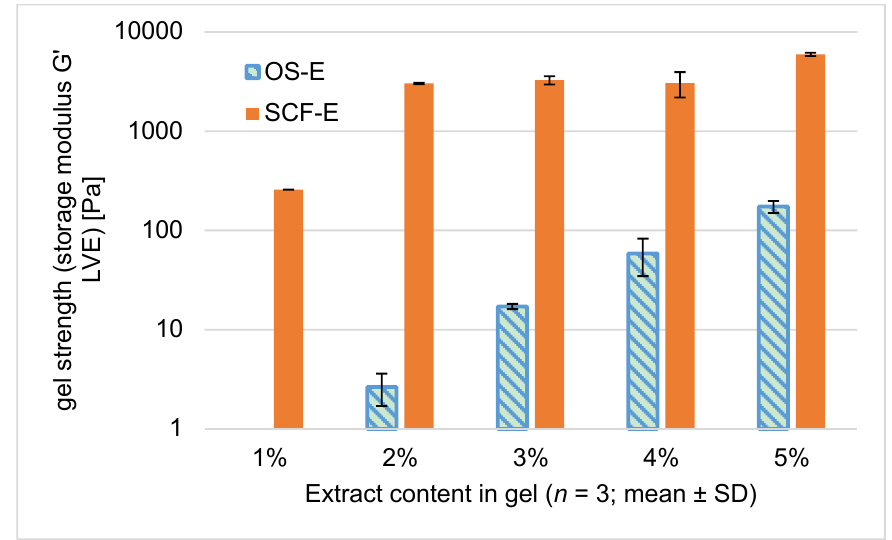
Figure 9. Gel strength (amplitude sweep) as a function of extract content in gels, stabilised by organic solvent and supercritical fluid extract; n = 3, mean ± SD.